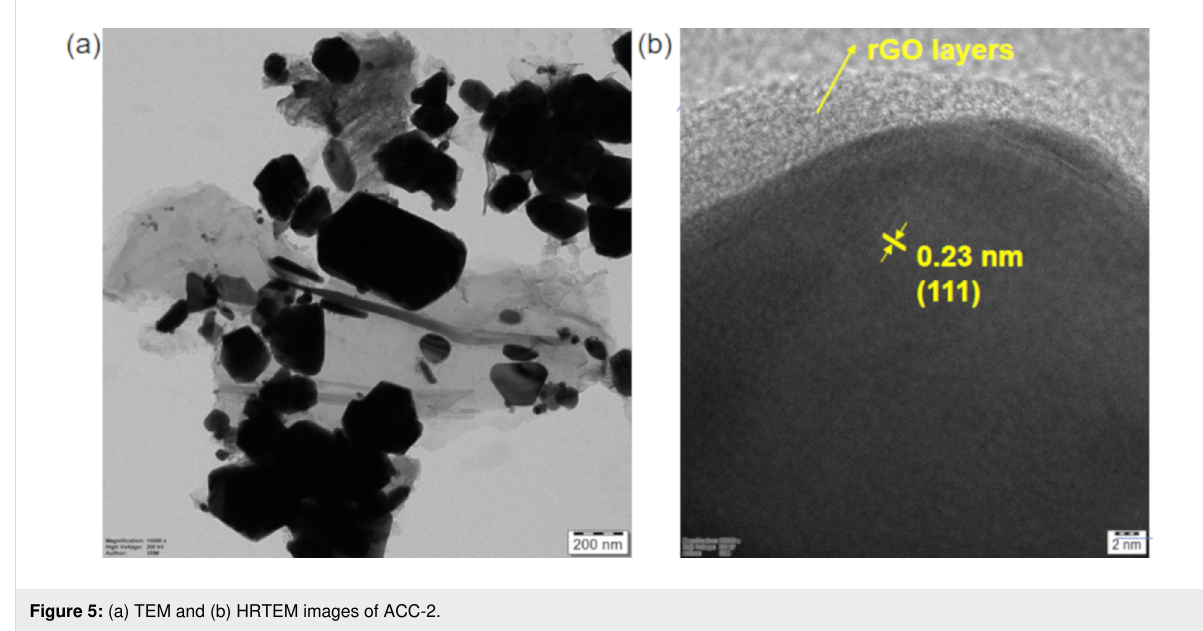
Figure 5: (a) TEM and (b) HRTEM images of ACC-2.